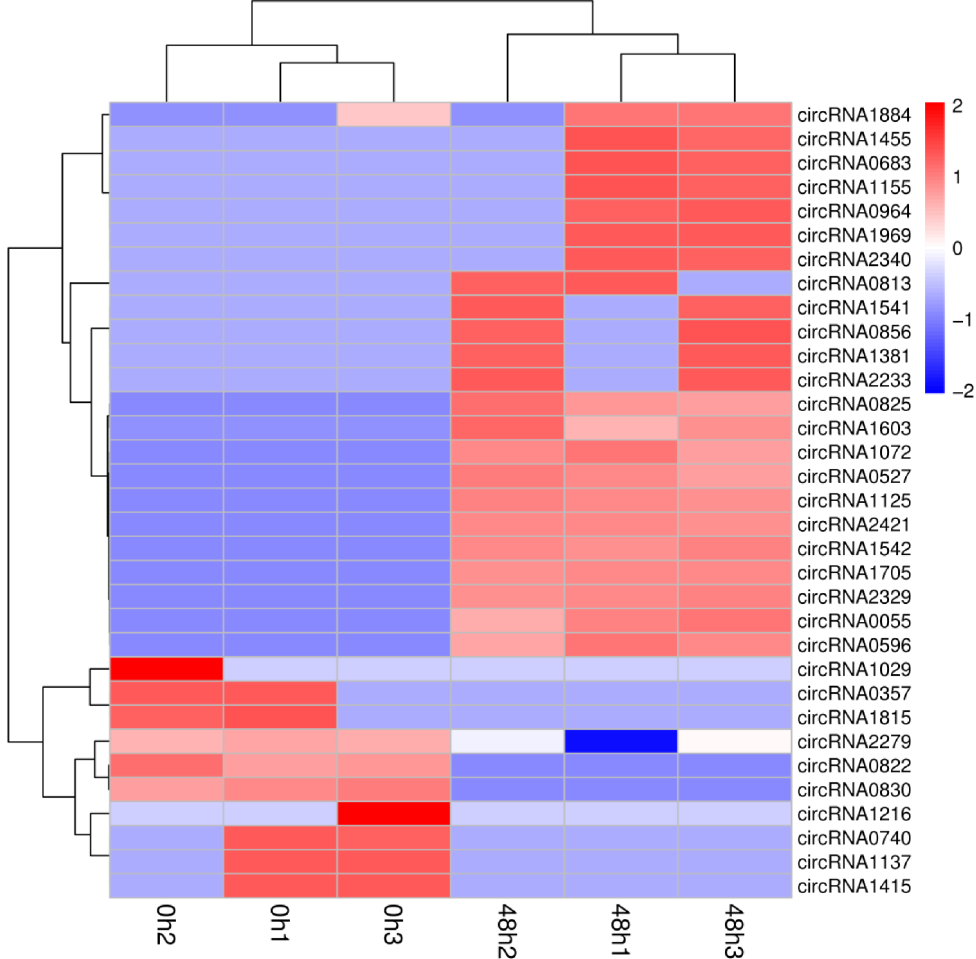
Fig 3. Heat map of differentially expressed circRNAs under drought stress compared with